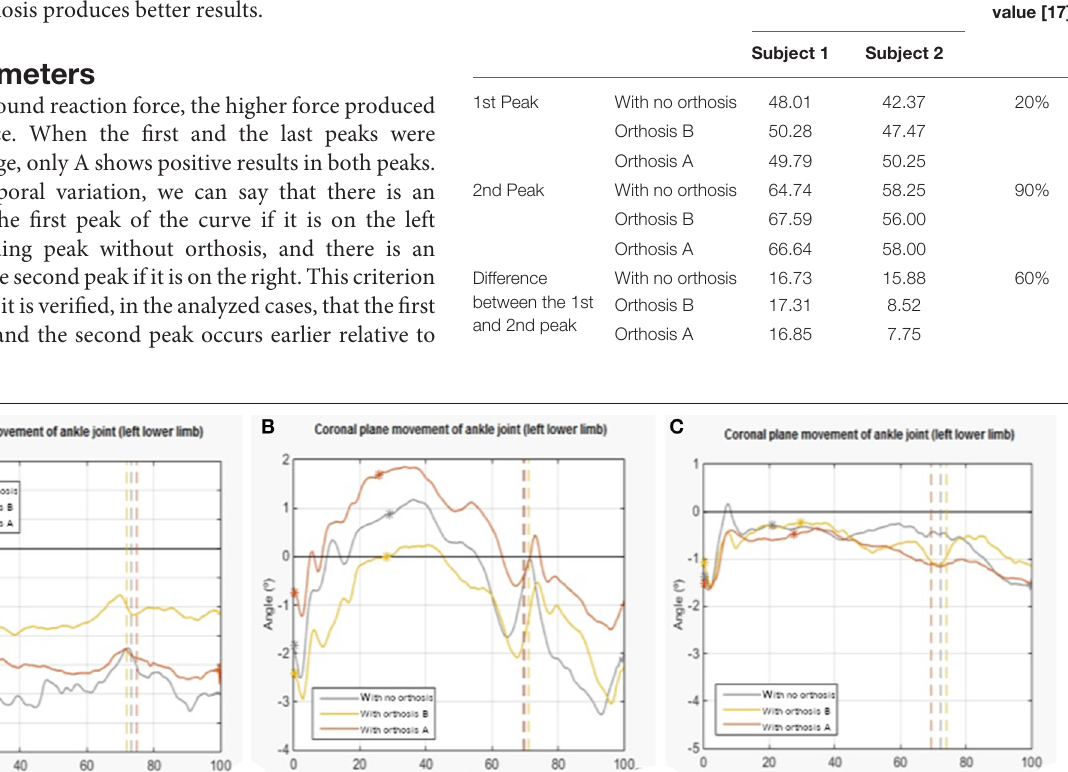
TABLE 3 | Mean values of the affected lower limb at the moment when the two peaks of reaction force of the soil occur. Average value ( ± 0.01% support phase)